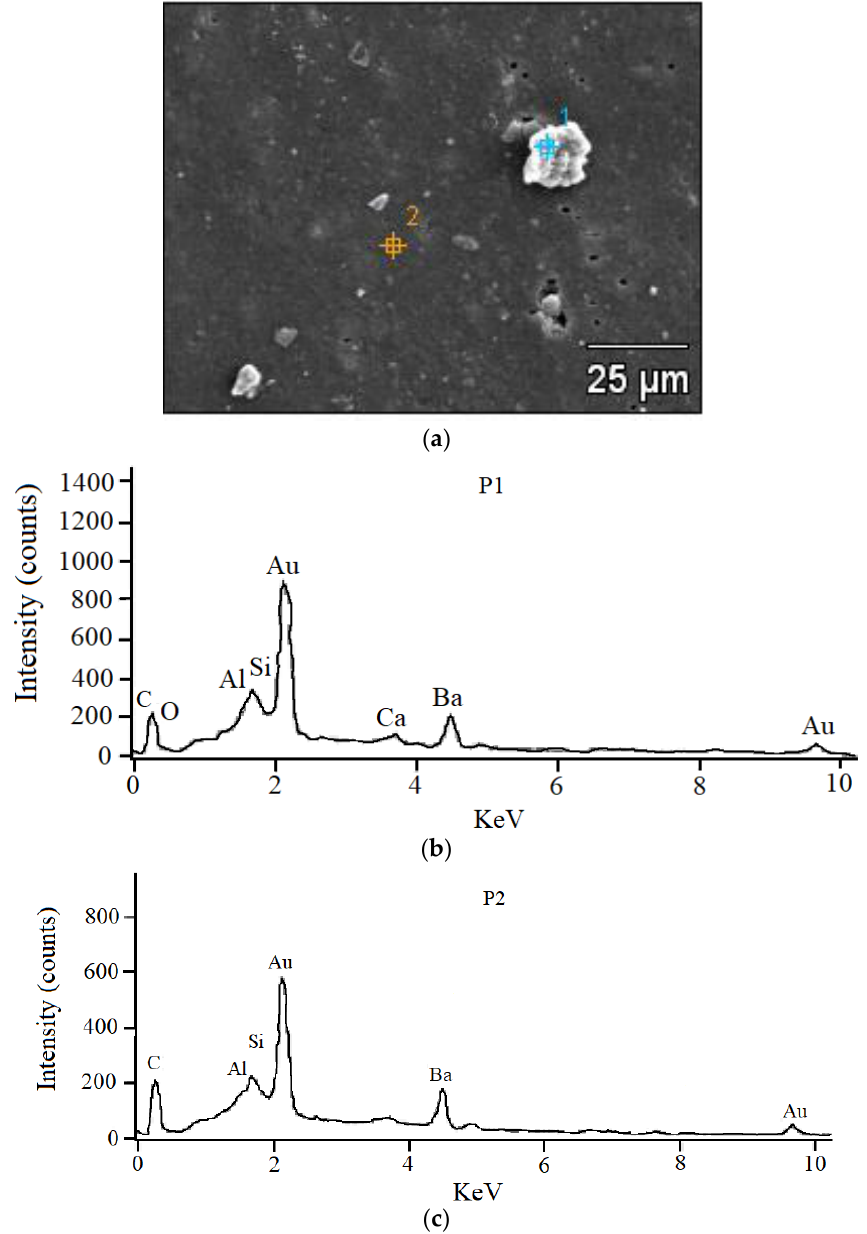
Figure 4. ( a) SEM of the surface of a CEP film with 1000× magnification. The EDX is from two film Figure 4. ( a ) SEM of the surface of a CEP film with 1000 × magnification. The EDX is from two film surface analysis locations, (b) P1 and (c) P2. surface analysis locations, ( b ) P1 and ( c )